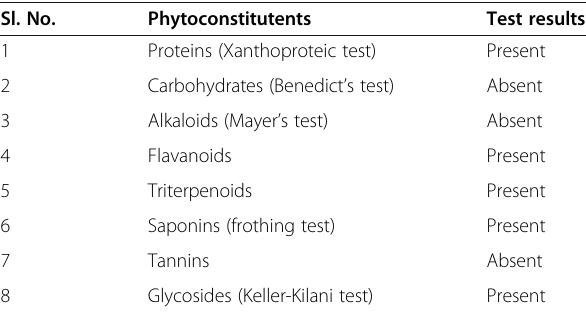
Table 1 Phytochemical screening of the methanol extract of Artemisia vulgaris Sl. No.